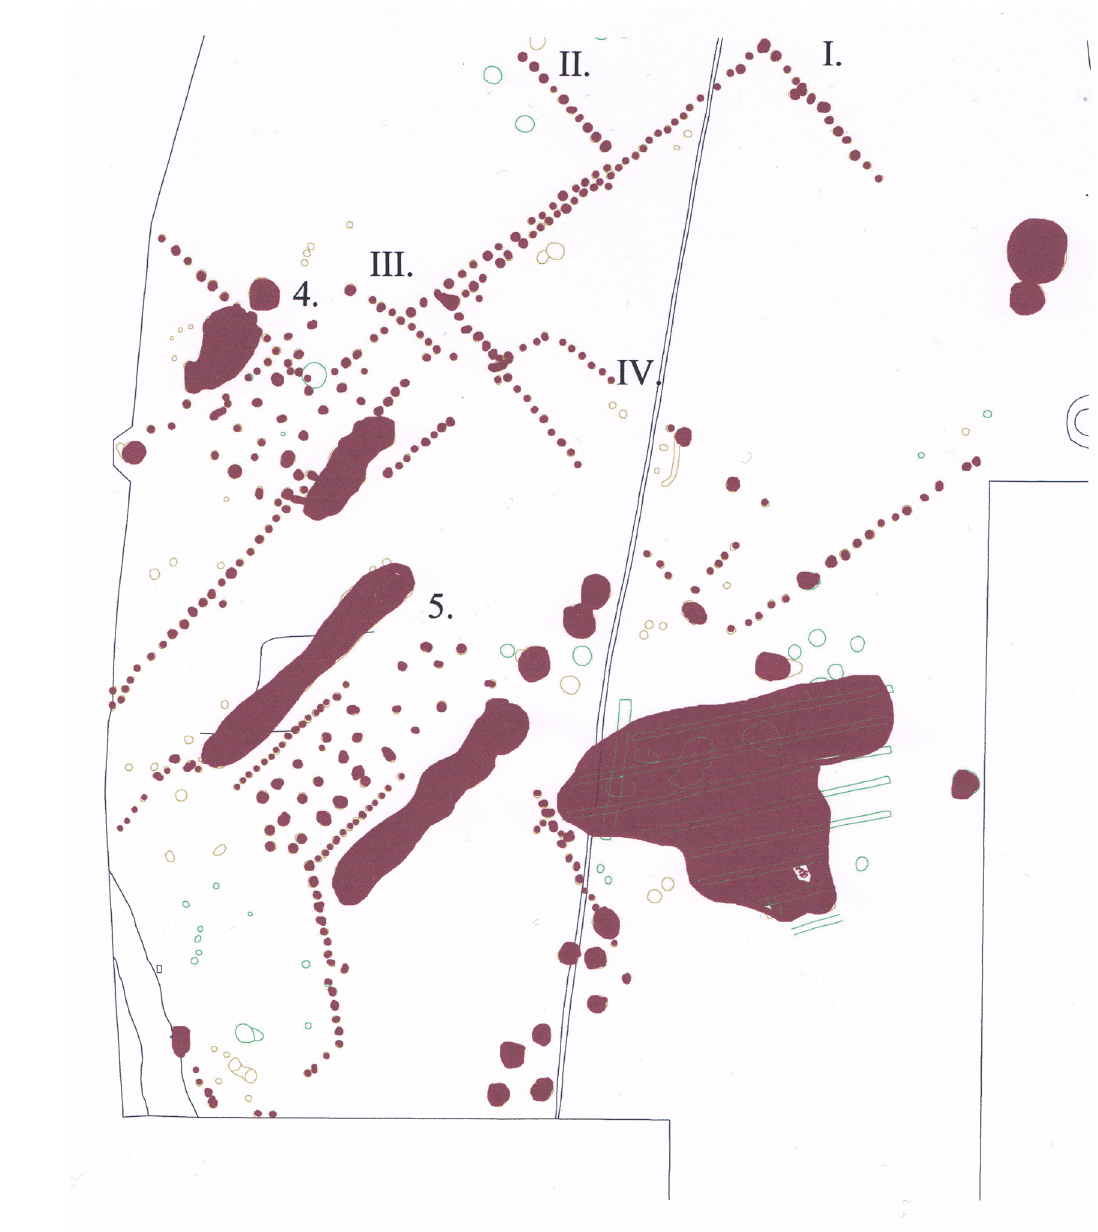
Figure 1: Harta (Hungary). Linear Pottery house No.5. After Kustár, Lantos, Hajnalová, Sümegi